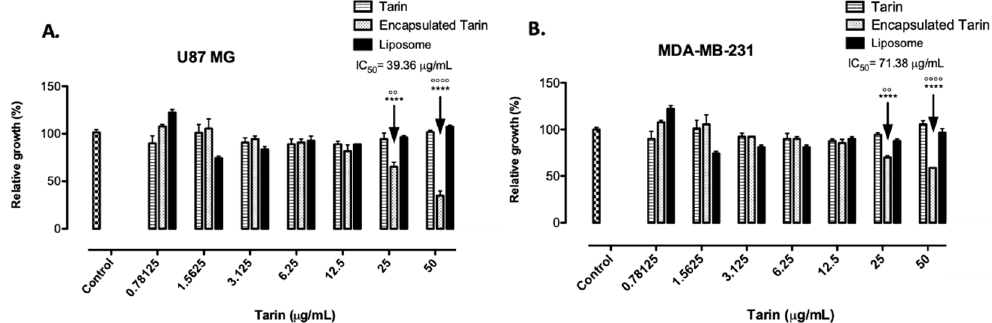
Figure 6. Toxicological effects of free or encapsulated tarin on human tumoral cells. Viability of human ( A ) glioblastoma U-87 MG cell line and ( B ) adenocarcinoma MDA-MB-231 cell line. Non-treated wells, filled with cells and medium, were used as control. To unify the units represented in x axis, tarin concentrations were chosen as reference. Liposome and encapsulated tarin groups are at the same liposome concentration differing only by the presence of tarin. **** p < 0.0001 compared to control; ◦◦ p < 0.01 and ◦◦◦◦ p < 0.0001 compared to free tarin.